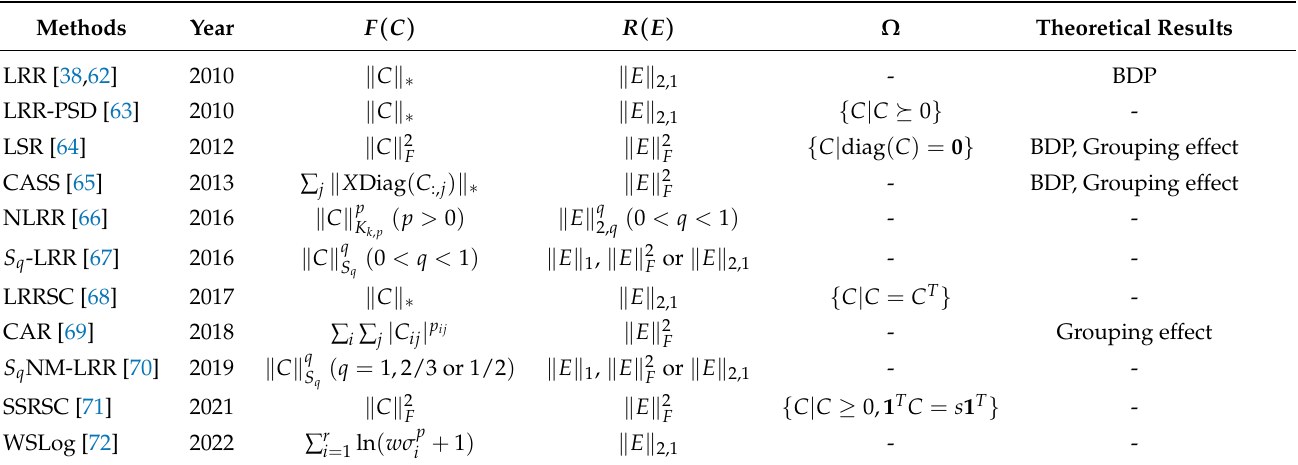
Table 3. The comparison of classical low-rank SC